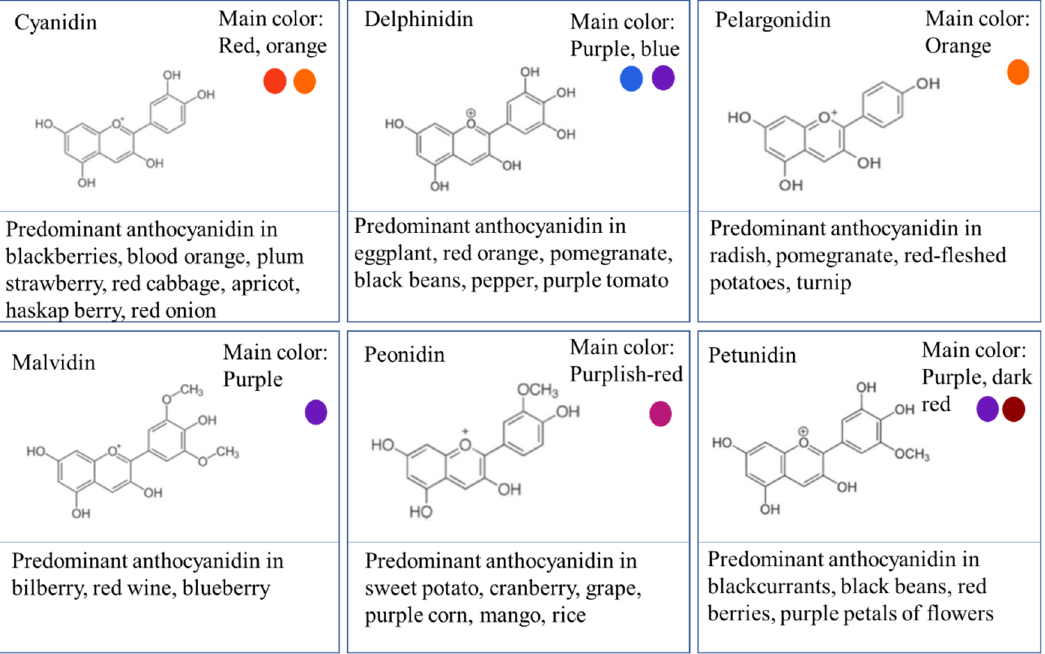
Figure 1. Chemical structures, colors, and sources of the most important anthocyanidins [2]. Microencapsulation is a satisfactory resolution regarding effectively protecting an- thocyanins against adverse environmental conditions, and at the same time, providing physical stability, controlled release over time, enhanced bioaccessibility, and ease of han- dling and storage. In this process, a multicomponent structure is formed via entrapment of the solid, liquid, or gaseous substances as an active core material into a polymer as a wall or carrier material [10–12]. The products achieved using this process are different in size, ranging from 1 to 1000 µ m. The morphologies generated via microencapsulation are also diverse, including microspheres, microcapsules, and microparticles (Figure 2). In microspheres, the core material is dispersed in the matrix and on the surface, which is different from microcapsules. Microcapsules could either be mono- or polynuclear, where in the former, a single active compound is coated by a wall material, while the latter consists of two or more cores. The wall material with which the active ingredient is